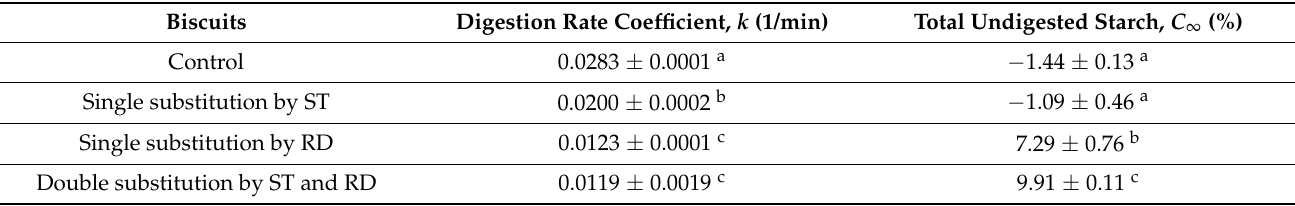
Figure 1. In vitro digestion curves of control and substituted biscuits, averaged from duplicate measurements. Table 5. In vitro digestibility of control and substituted biscuits .